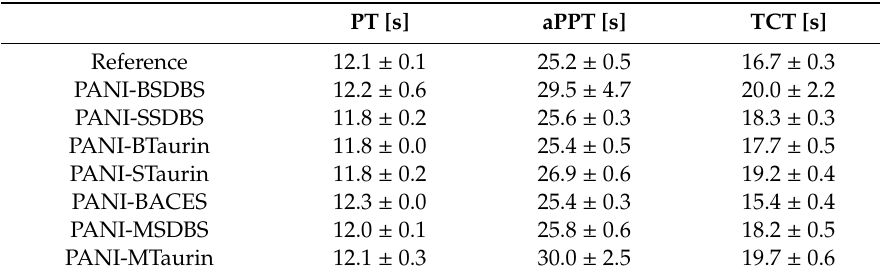
Table 3. Impact of PANI with modified surfaces on selected coagulation parameters, prothrombin time (PT), activated partial thromboplastin time (aPPT), thrombin clotting time (TCT), expressed as times to the coagulation